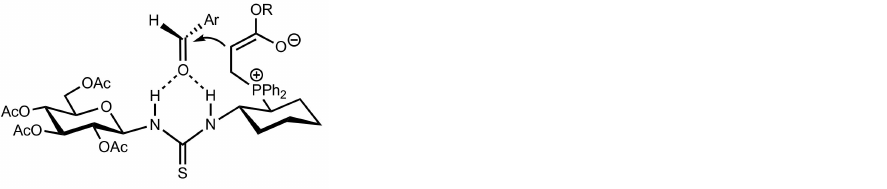
Figure 17. The proposed transition state for the Morita–Baylis–Hillman reaction catalysed by 133 .